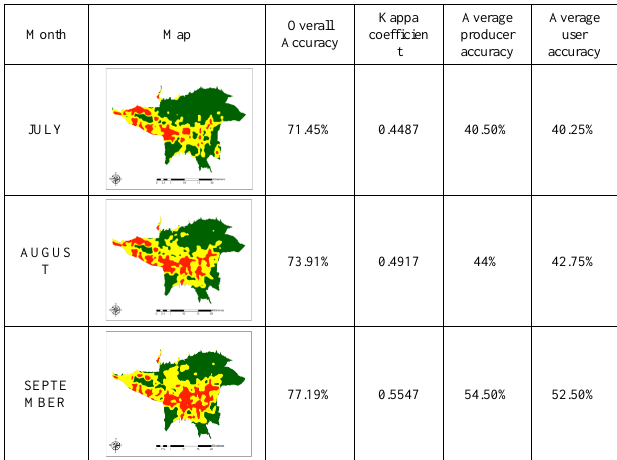
Table 4. Maps and results for the third quarter of 2014 (green: Clear, Yellow: low density, red: high density)